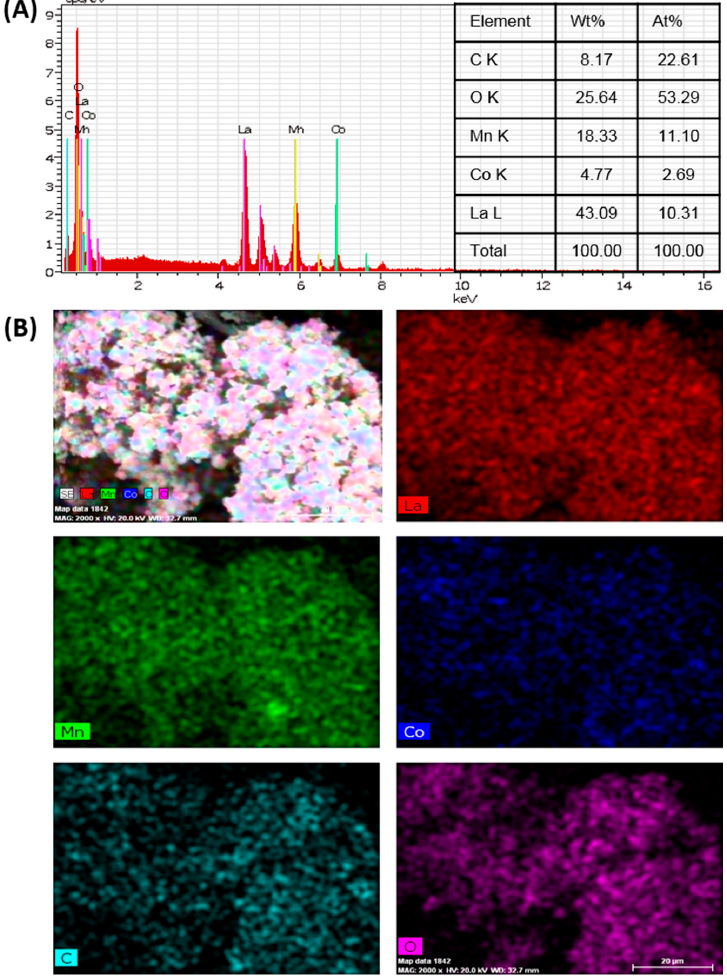
Figure 2. ( A ) EDX spectra for qualitative and quantidative analysis for the La, Mn, Co, C and O elements present in the LaMnO 3 @C-Co 3 O 4 composite; ( B ) EDX elemental mapping of LaMnO 3 @C- Co 3 O 4 composite.